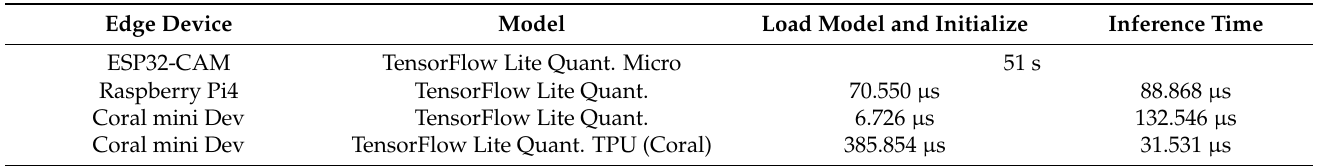
Table 4. Processing time for all edge devices on the same quantized model: (a) load models and initialize the inference procedure, (b) process an image and derive a count of the insects inside.